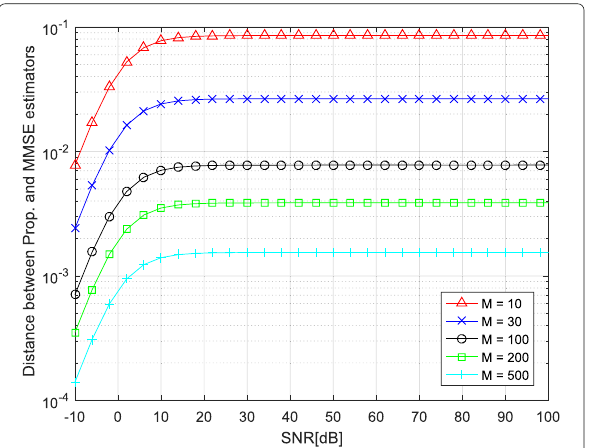
Fig. 7 Distance between proposed and MMSE estimators (Remark 5)